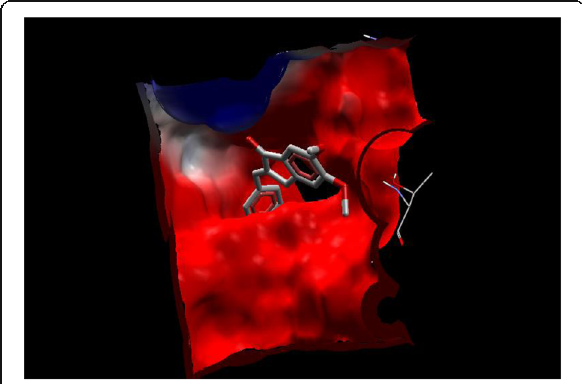
Fig. 7 Electrostatic interaction of donepezil in the active site of AchE